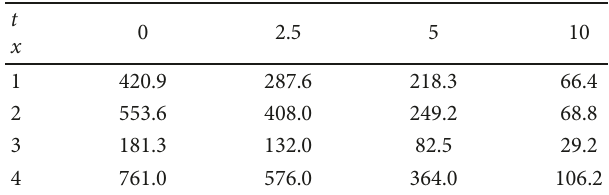
Table 4: Some data of VaR ζ g ∗